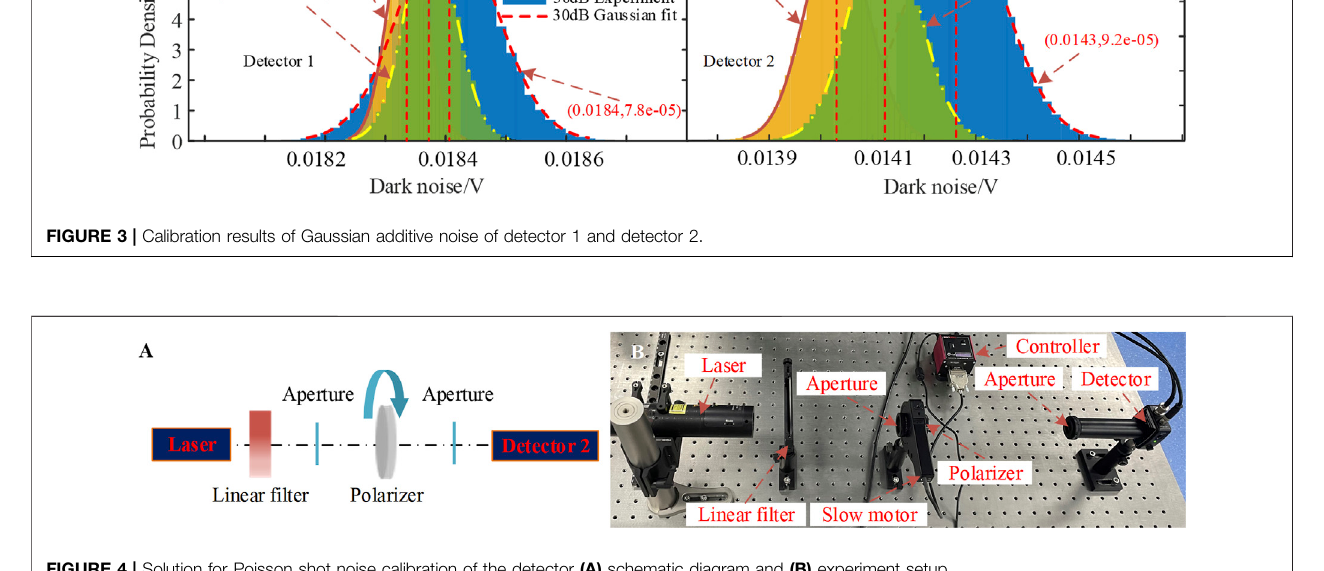
FIGURE 4 | Solution for Poisson shot noise calibration of the detector (A) schematic diagram and (B) experiment setup.